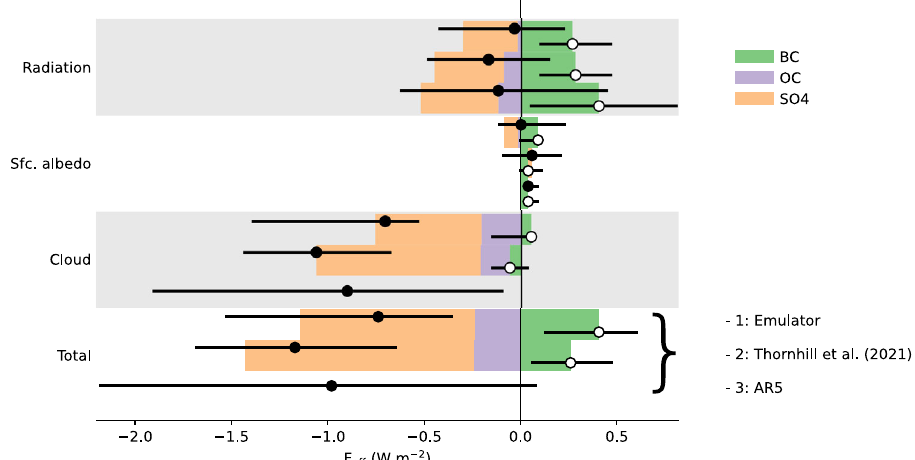
Fig. 6 Comparison of global mean aerosol effective radiative forcings in the emulator with results from the 5th and 6th IPCC assessment report. The estimates from this study (bar 1), 6 th IPCC assessment 4,55 (bar 2), and 5 th IPCC assessment 57 (bar 3) refer to a different reference year for present-day: 2015 (bar 1), 2014 (bar 2), and 2005 (bar 3), relative to pre-industrial conditions in 1850. Black bullets refer to net radiative forcings for each emitted species (see the section on methods for details). White circles refer to the contributions of black carbon (BC) to the net radiative forcings. Contributions of different aerosol species (sulfate, organic and black carbon) are shown, where available (colors indicated in the legend). Global sulfur emissions in the AMAP inventory used in the emulator are low compared to emissions used for the IPCC assessments (Fig. 1), which partly explains differences in sulfate radiative forcings. Con fi dence intervals (error bars) are indicated by black horizontal fi rst downscale the PM 2.5 concentrations that are simulated in the 3D models using satellite-based data. This allows us to conduct the emulator simulations at a resolution of 0.5° latitude and longitude. The downscaled concentrations from the models are averaged and scaled linearly by the speci fi ed regional emission changes to obtain gridded and annual mean concentrations. The rigorous linearization of complex physical and chemical atmospheric processes in the emulator can limit the accuracy of simulated concentration responses involving non-linear processes. However, the emulator reproduces the simulated PM 2.5 trends in the ESMs during the simulation time period of interest. The climate component of the emulator is based on simpli fi ed models of the heat, carbon and air pollutant cycles in the global Earth System. The simplicity of the emulator allows us to compare the climate in fl uences of anthropogenic emissions of CO 2 , CH 4 , CO, NO x , VOC, sulfur, BC, and OC. No other chemical species are represented in the emulator. On the other hand, ESM simulations usually account for more species and emission sources than we consider here, which limits comparisons between the simulated total warming trends in the emulator and ESMs. However, the focus of our study is on comparisons for SLCFs and CO 2 climate impacts, which can be approximated to be independent of other species. It is possible to add other chemical species to the emulator, as needed. The model parameterizations are constrained by effective radiative forcing sensitivities from a series of equilibrium simulations with regionally perturbed emissions in CanAM5-PAM, CESM2, MRI-ESM2, and UKESM1. The emulator simulates global and Arctic temperature changes, assuming a linear relationship between the emissions and effective radiative forcings for the different regions, similar to the simulation of PM 2.5 concentrations. Separate effective radiative forcing sensitivities were obtained for each emitted species, region, and forcing process, for interactions of aerosols with radiation, clouds, and the surface albedo (snow and ice). For global effective radiative forcings of CO 2 and CH 4 , global atmospheric greenhouse gas mass budgets are simulated which account for key physical and chemical loss processes. A more detailed description of the emulator is available 40 . Simulated global aerosol effective radiative forcings in the emulator are comparable to results from previous multi-model based assessments (Fig. 6). Compared to an earlier assessment of Arctic climate by AMAP 41 , differences in simulated forcings are due to a combination of differences in regional emissions, time periods, and changes in the climate models that were used to generate the radiative forcing sensitivities. The ESMs that we used to calculate effective radiative forcing sensitivities tend to produce concentrations of BC that are too low, especially in the Arctic (Supplementary Note 3), which indicates that BC effective radiative forcings in the emulator may also be low. Given the concentration biases and the tendency of the ESMs to underestimate absorption aerosol optical depth, we cannot rule out larger impacts of BC on effective radiative forcings and temperatures than our best estimates provided here. The Arctic temperature responses to radiative forcing changes are simulated accounting for transport of heat to the Arctic but omitting natural climate variability, changes in natural air pollutants, and land-use. Speci fi cally, the emulator simulates the forced response of the global and Arctic mean surface air temperatures to a series of annual emission pulses. The temporal evolution of the